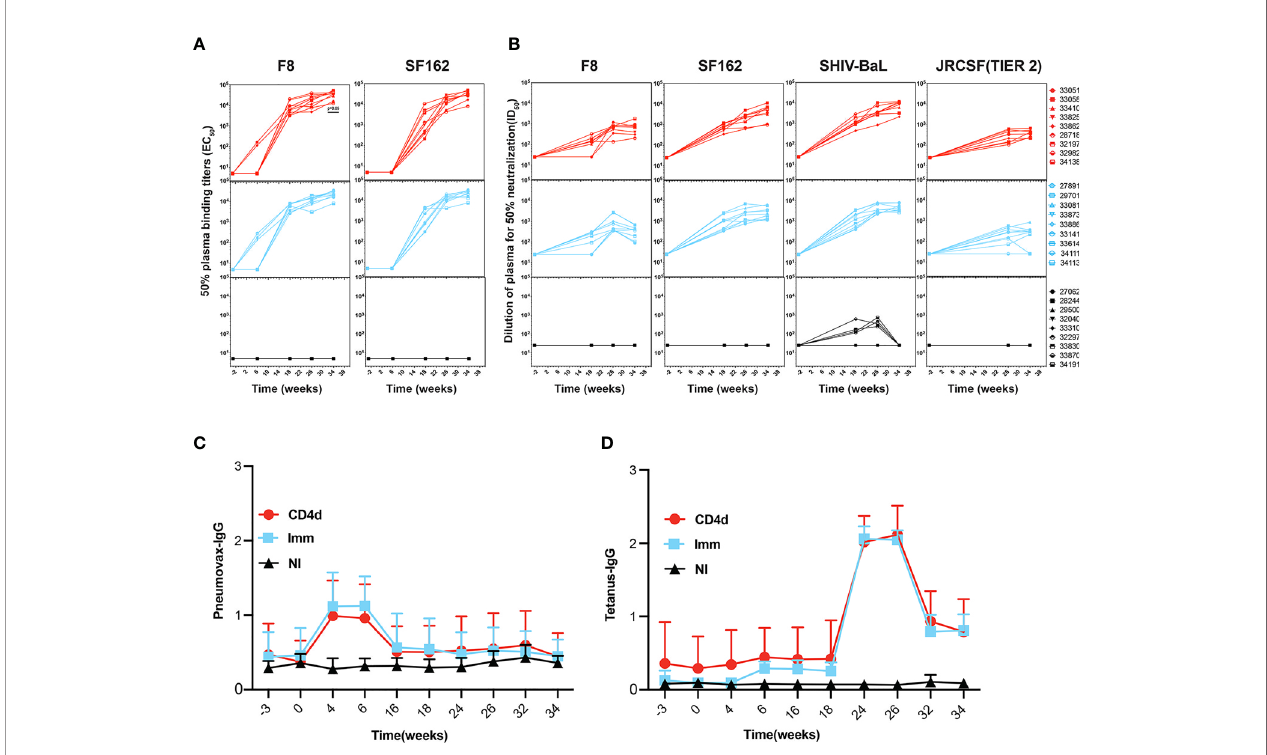
FIGURE 3 | Rhesusmacaques develop longitudinal autologousandheterologous Env-speci fi c antibodies. (A) F8-gp140 and SF162-gp140 speci fi c plasma IgG was determined byELISA. Symbol represented individual rhesus macaques. (B) Plasma samples from VC10014-vaccinated macaques were tested longitudinally for neutralization antibodies to F8, SF162, SHIV-BaL, andJRCSF(Tier 2) byTZM-blassay.LongitudinalELISA showing Pneumovax (C) andTetanus (D) speci fi c plasma IgG. Red=CD4depleted (CD4d) group, turquoise =Immunized (Imm) group, black=Non-Immunized(NI) group. Signi fi cance isdetermined bytwo-tailed unpaired t-test (p ≤